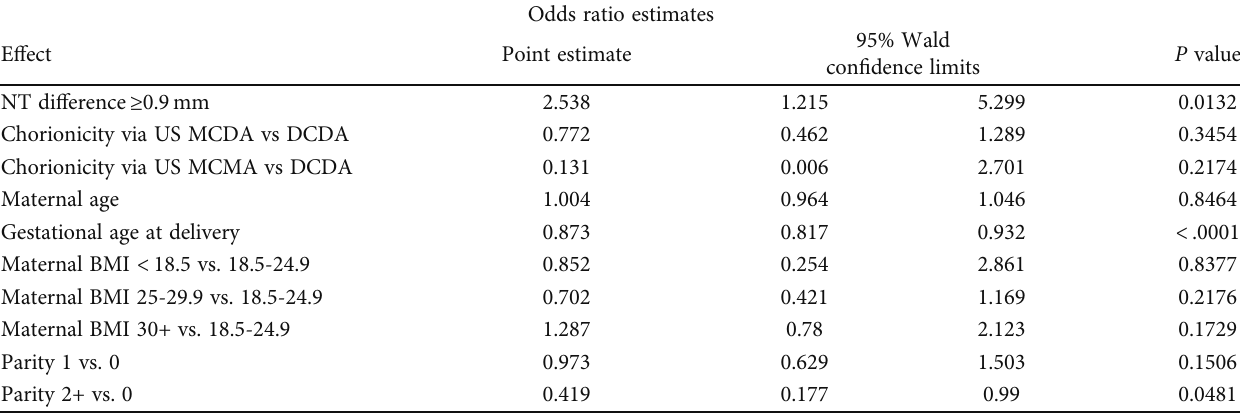
Table 5: Multivariate probability modeling the e ff ect of NT di ff erence ≥ 0.9mm (95 th percentile) on birth weight